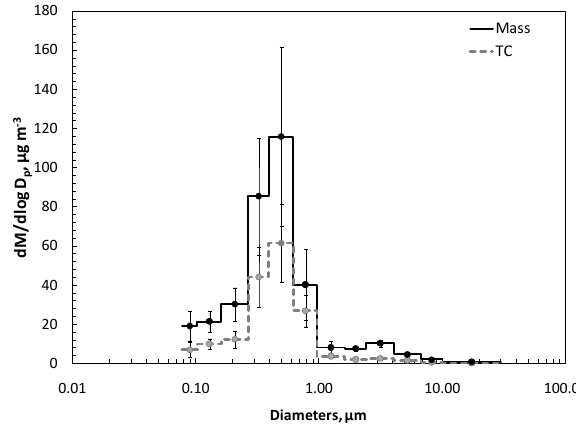
Fig. 1. Average particulate mass and TC size distributions during the dry period. The size distribution for the mass and TC concentra- tions are the average for all samples collected on aluminum foil sub- strates during the dry period ( n = 6). Error bars represent the stan- dard error (standard deviation divided by the number of